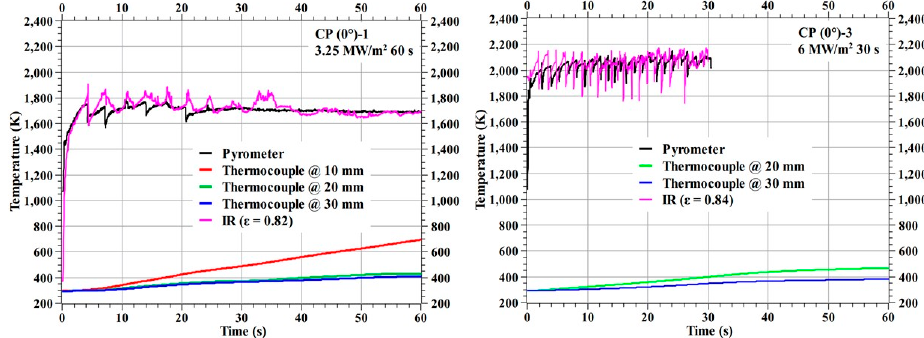
Figure 7. CP (0°)-1 and CP (0°)-3 temperature responses.